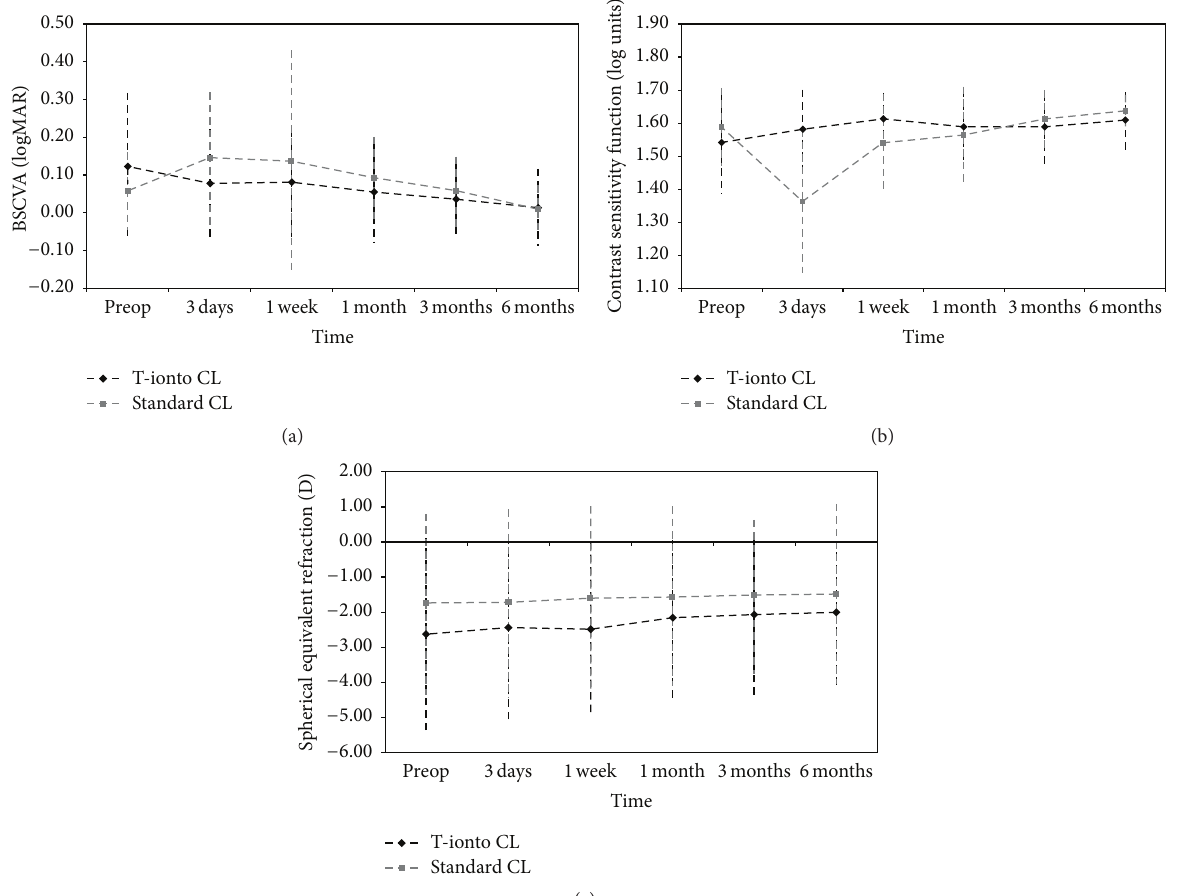
Figure 5: ((a), (b), and (c)) Graphs showing best spectacle corrected visual acuity (BSCVA, LogMAR), contrast sensitivity function (CSF, log units), and spherical equivalent refraction (D) compared with baseline at 3 days, 1 week, and 1, 3, and 6 months after T-ionto CL (black curve) and standard CL (grey curve), respectively. Bars indicate ± standard deviation. BSCVA improved significantly ( 𝑃 = 0.08 ) and spherical equivalent refraction was significantly less myopic ( 𝑃 = 0.02 ) after T-ionto CL. On average, visual performance decreased in the first week after standard CL and reached preoperative values at 3 months